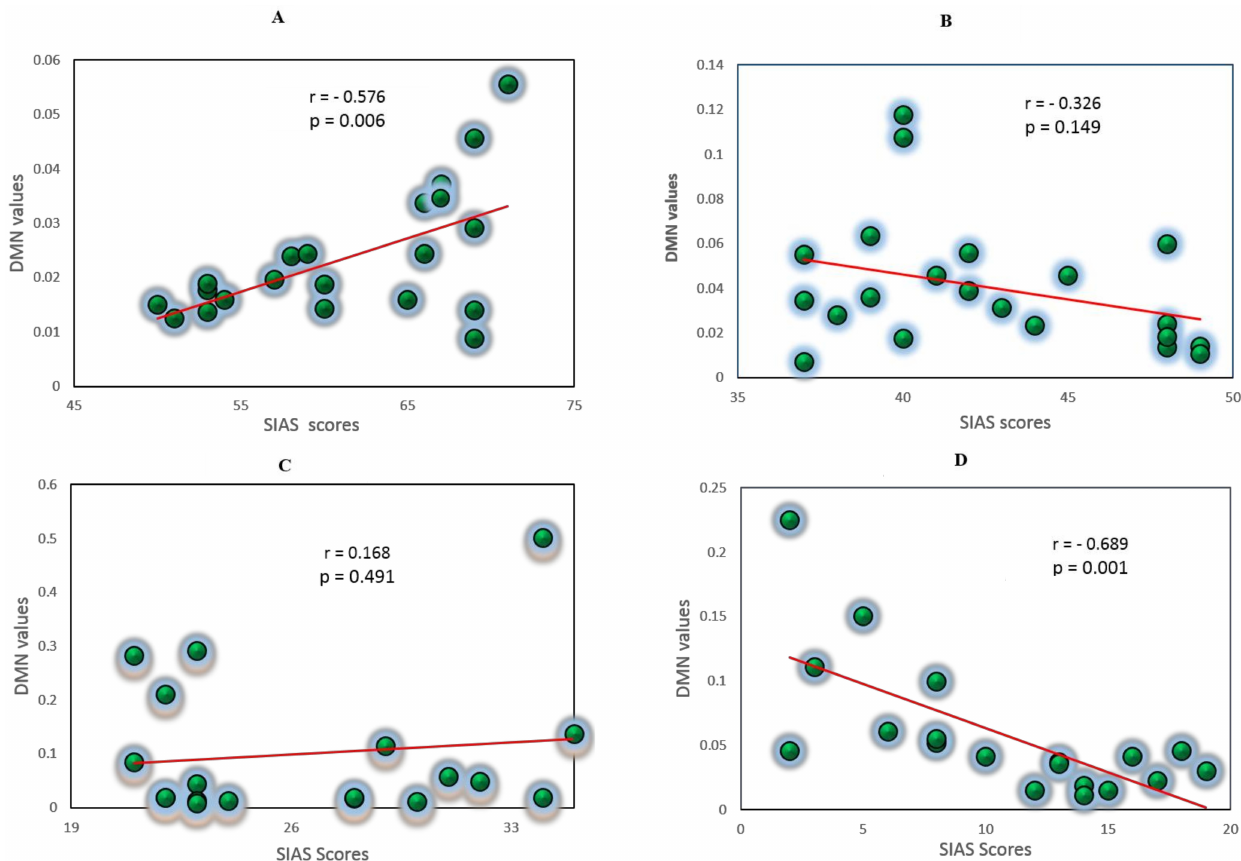
Figure 7. Correlation between the DMN-EC values and Social Interaction Anxiety Scale (SIAS) scores for the SAD groups, severe ( A ), moderate ( B ), mild ( C ), and control ( D ). Each circle represents a subject